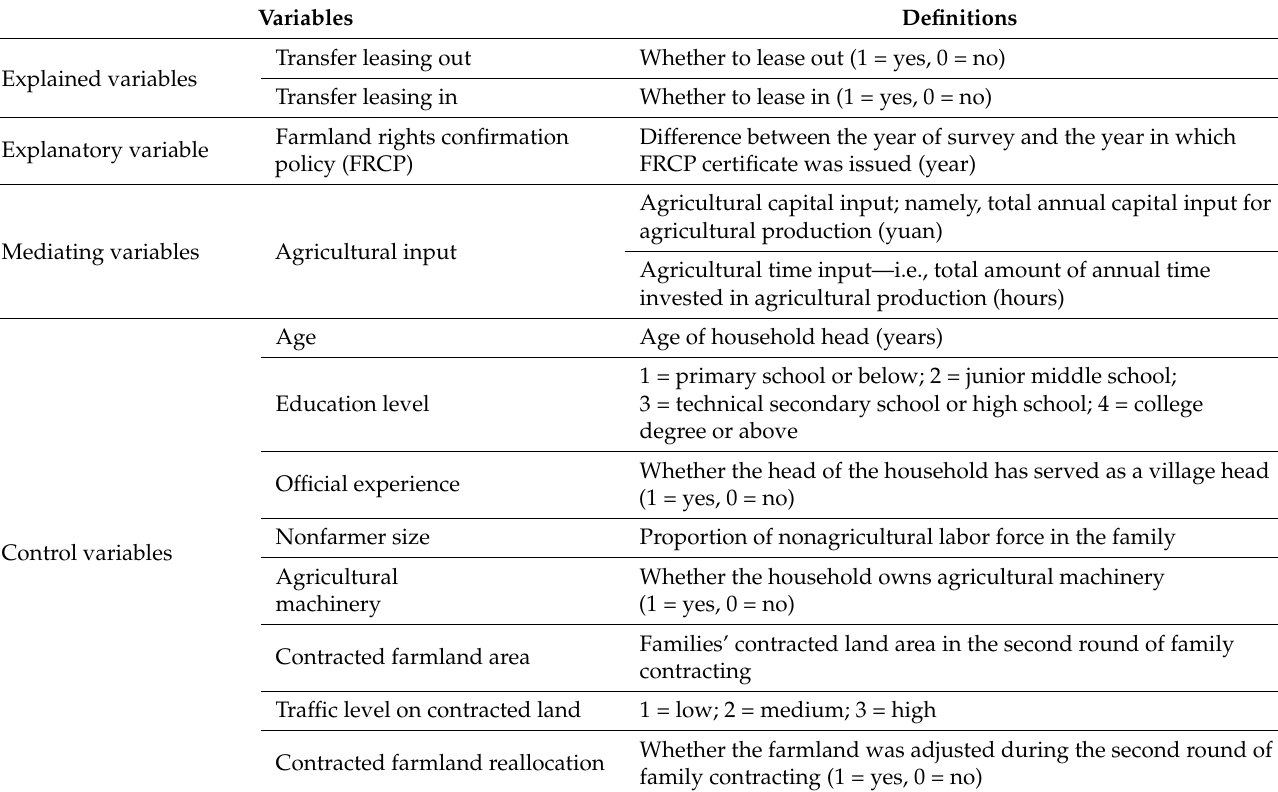
Table 1. The definition of the